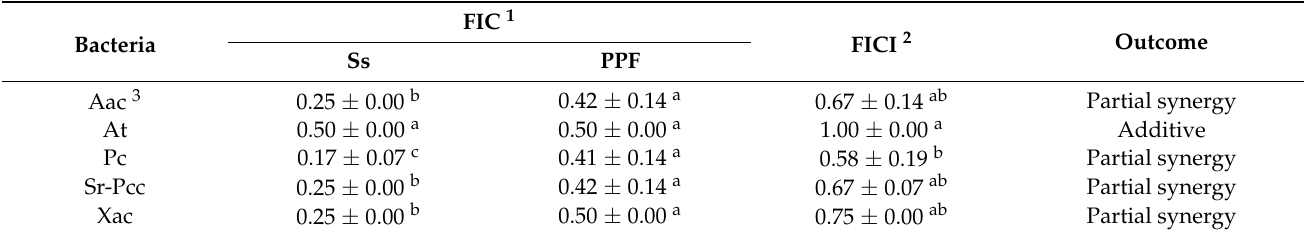
Table 4. Interaction of the partially purified fraction (PPF) and streptomycin sulfate (Ss) against streptomycin-resistant bacteria using checkerboard